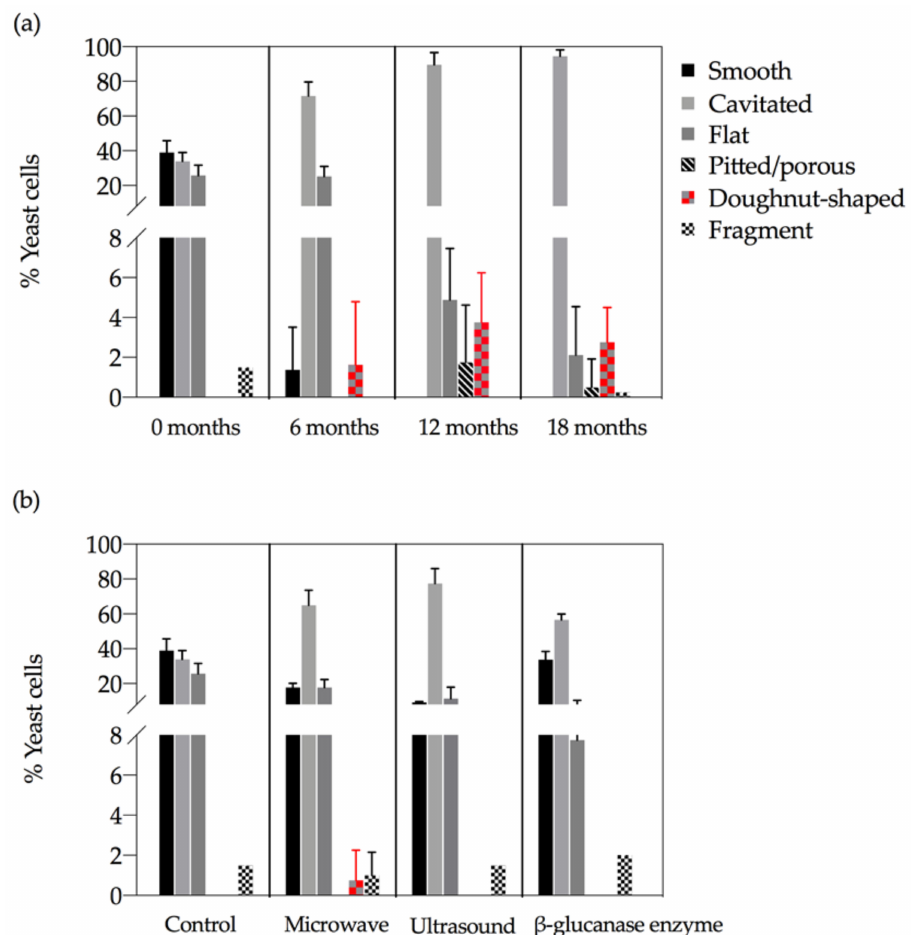
Figure 2. ( a ) Development of surface features over time on S. cerevisiae whole-cells in the control, and ( b ) Proportions of surface features observed in the control and the treatments at tirage (time